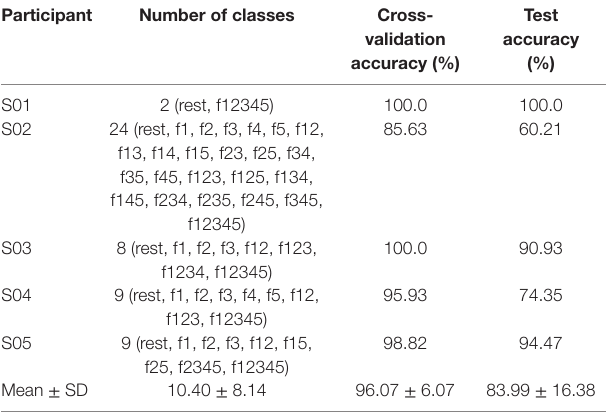
TaBle 6 | classification performance for participants with stroke (affected hand).